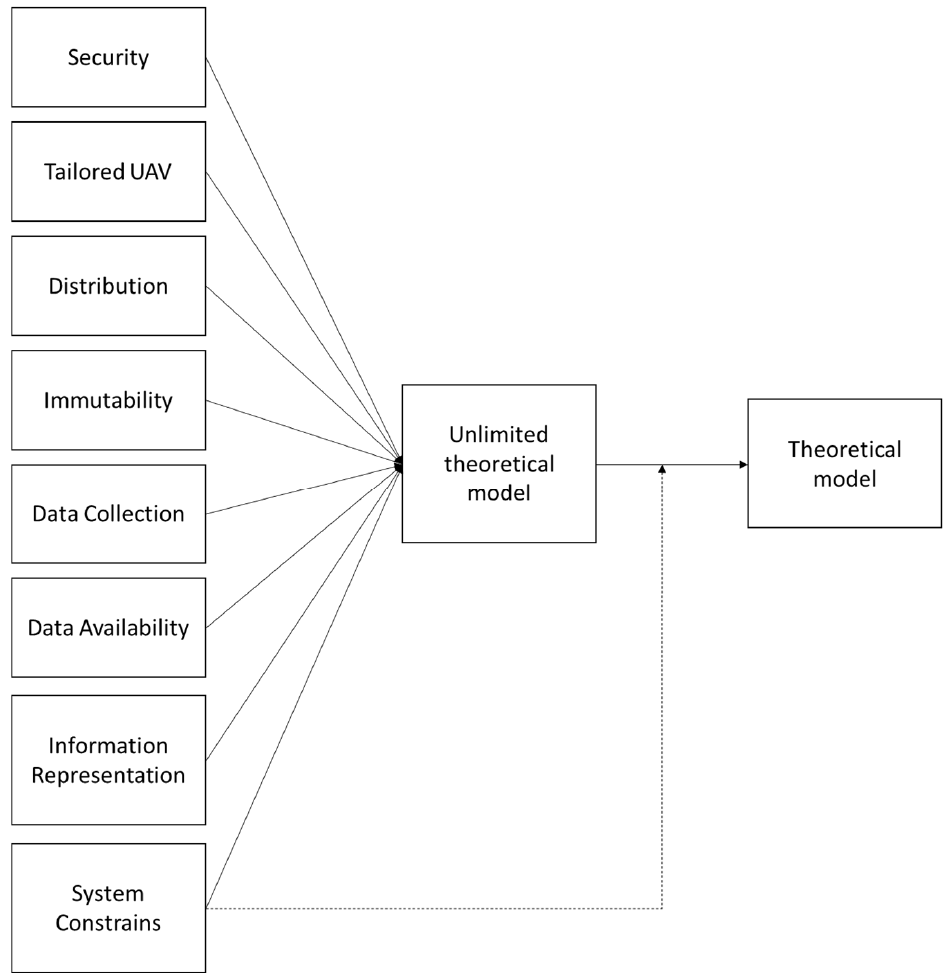
Figure 1. Theoretical model for the system proposal.